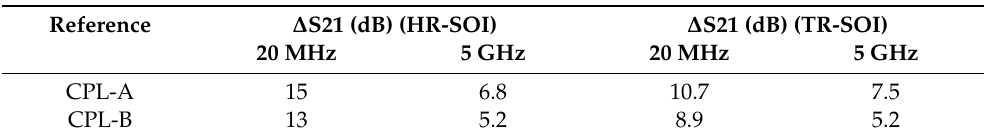
Table 2. ∆ S 21 values depicting the difference in substrate coupling before and after removal of substrate at chuck bias of 0